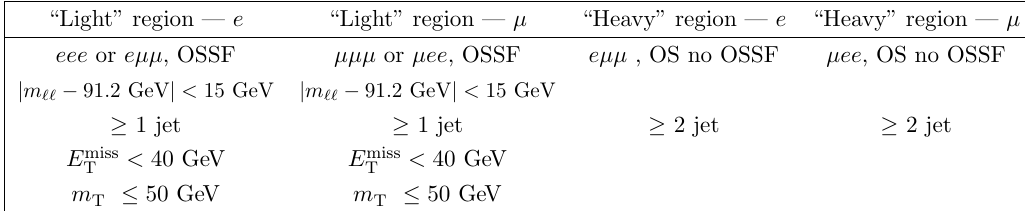
Table 3 . Selection criteria applied to derive the four scale factors of the non-prompt leptons background. OS indicates a pair of opposite-sign leptons, OSSF indicates a pair of opposite- sign, same-(cid:13)avour leptons. Additionally, events with at least two jets, one of them b -tagged, and 20 GeV < E miss < 40 GeV in the SR are rejected from the \light" T